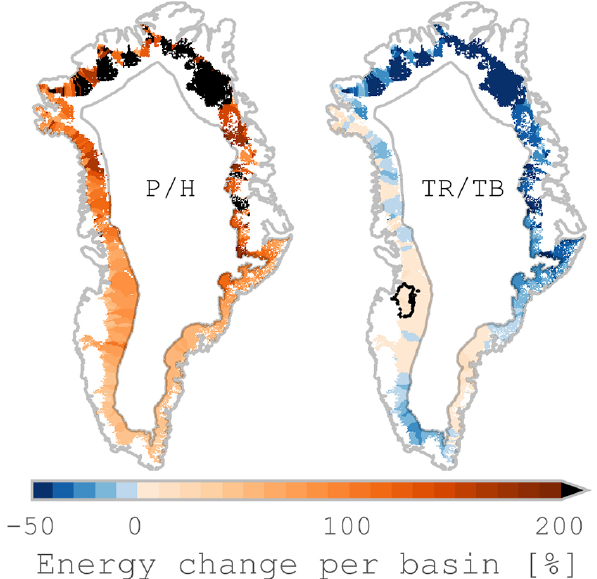
Figure 5. Relative change in VHD per basin highlighting the im- pact of different averaging periods. P/H is 100 × present divided by historical, and TR/TB is 100 × the reference (1985–1994) divided by baseline (2007–2014) years from Tedstone et al. (2015). Gray contours are 0 and 2000m elevation. Tedstone et al. (2015) study region highlighted with black contour line right